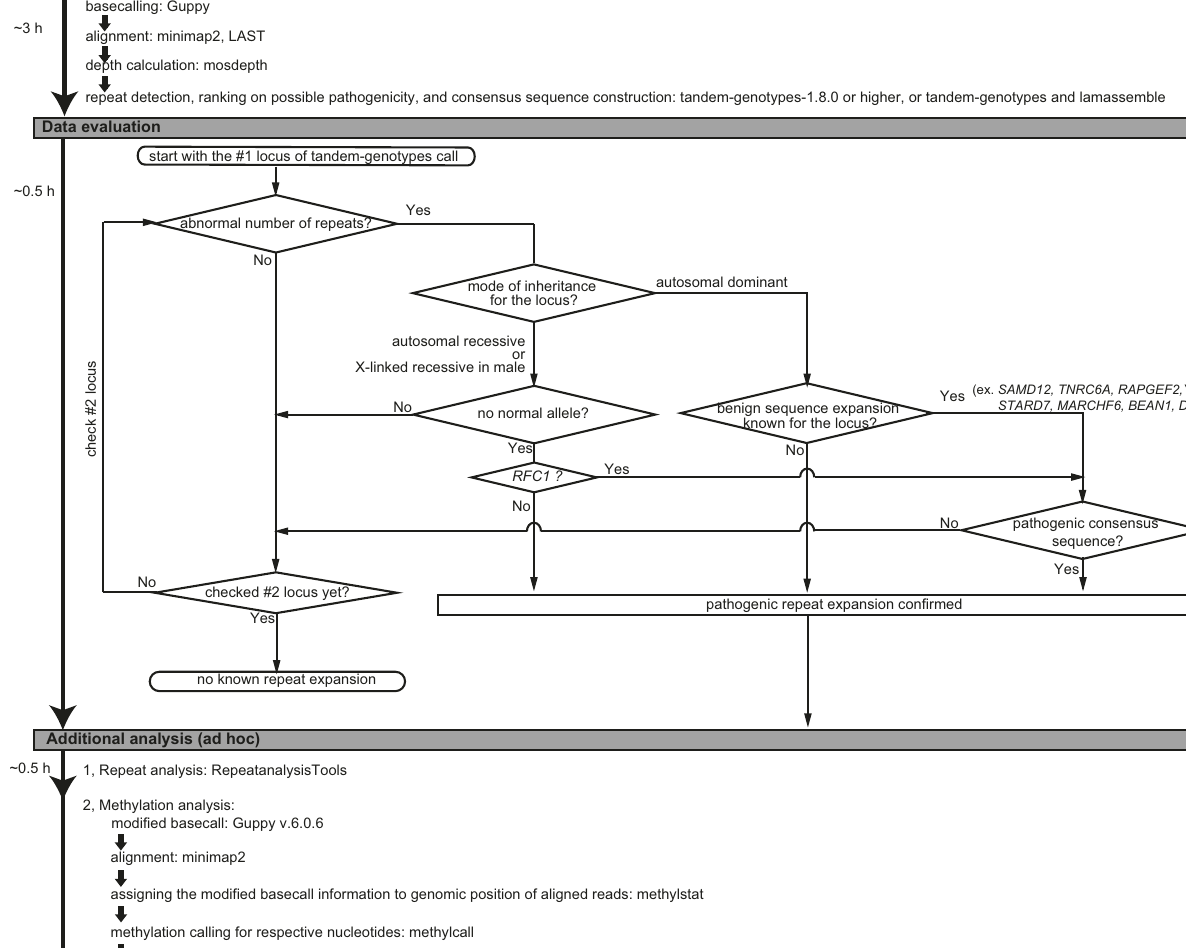
Fig. 3 Diagnostic fl owchart for human repeat expansion diseases using the GridION sequencer. The fl owchart for library preparation, sequencing, data analysis, data evaluation, and additional analysis (in an ad hoc manner) is shown along with the estimated time required for each